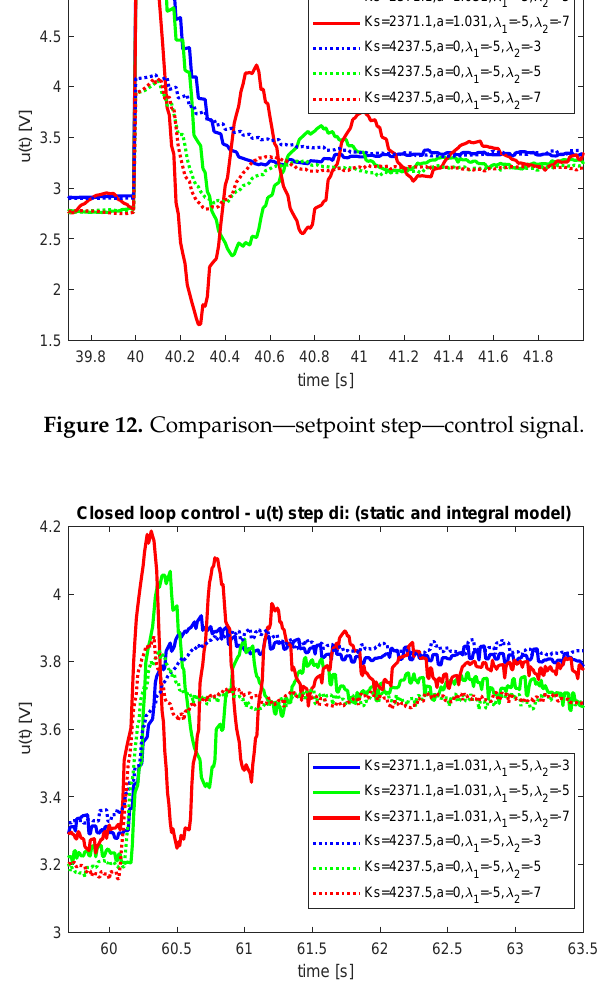
Figure 13. Comparison—disturbance step—control